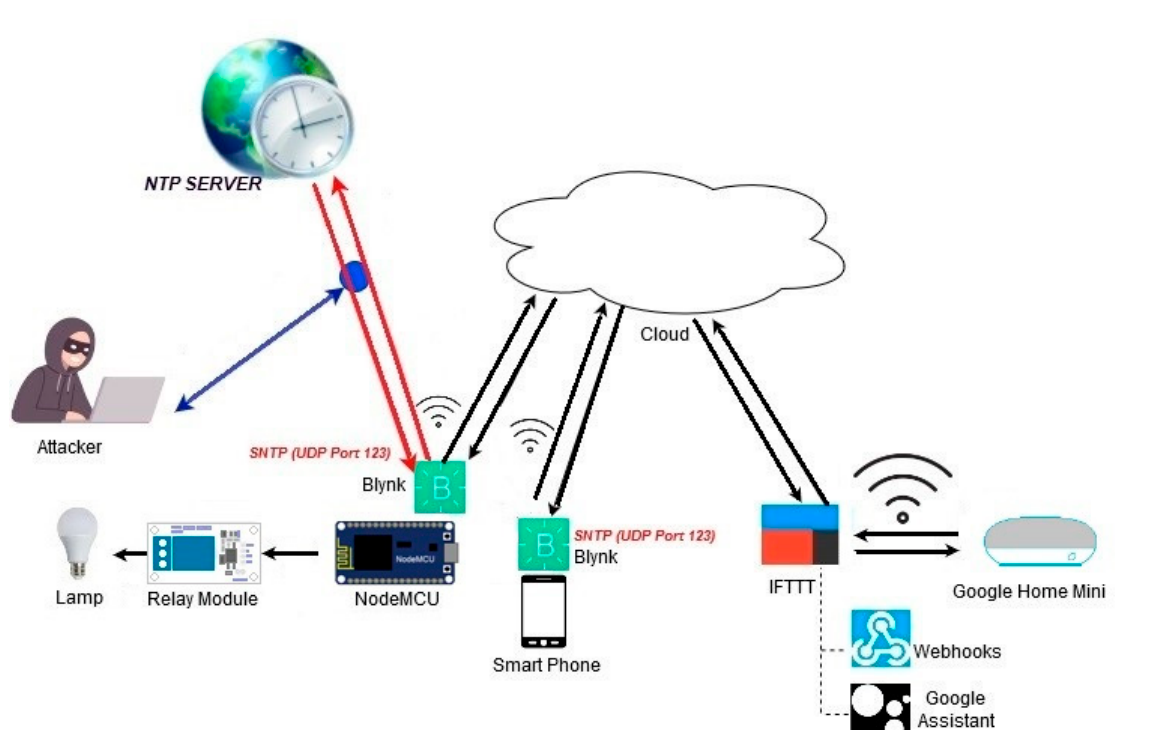
Figure 8. Attack scenario to the connection between Google Home Mini and NodeMCU.